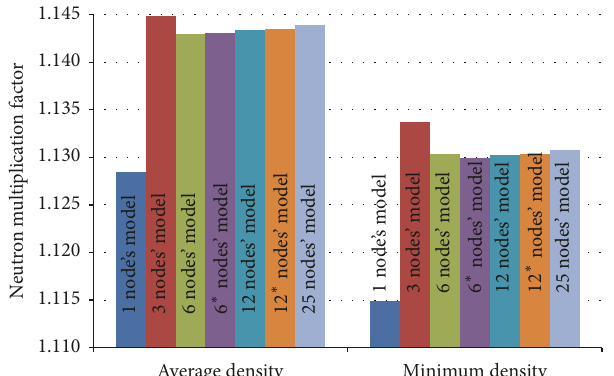
Figure 5: Neutrons multiplication factors calculated for separate density profiles.